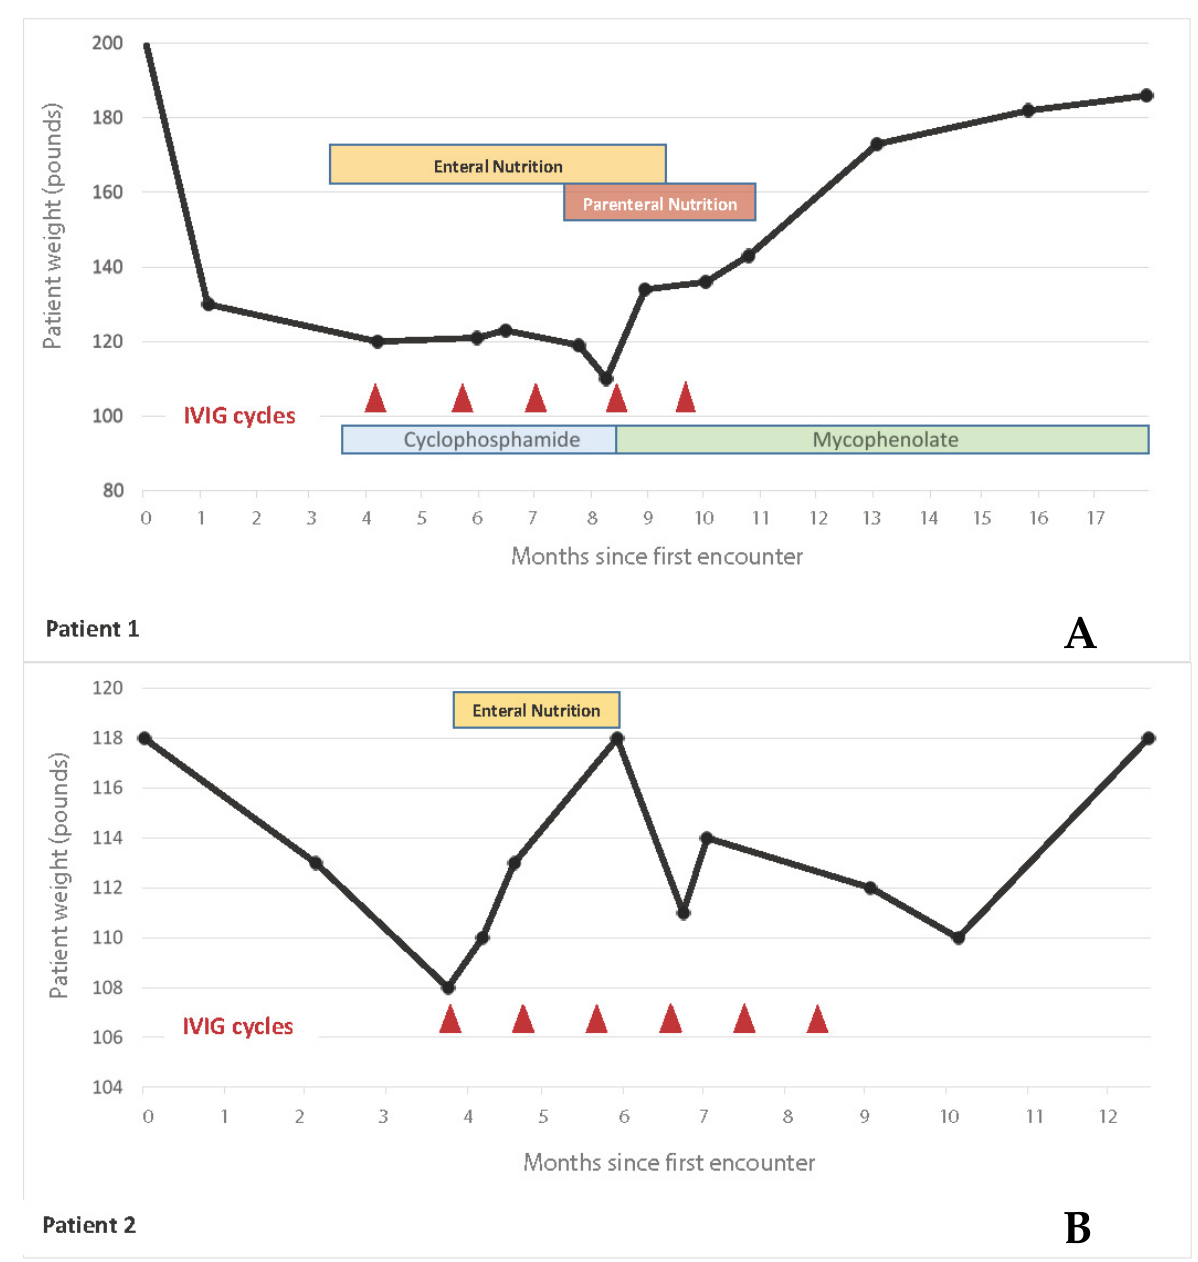
Figure 1. Evolution of weight, nutritional therapy, additional immunosuppressive therapy, and IVIG over one year. This figure shows patients’ weight trend (black line) over time in relation to IVIG cycles (red triangles) and adjunctive immunosuppression therapy (in patient 1) ( A ). Both patients were able to wean off nutritional support (enteral and parenteral nutrition in patient 1 and enteral nutrition in patient 2) ( B ).